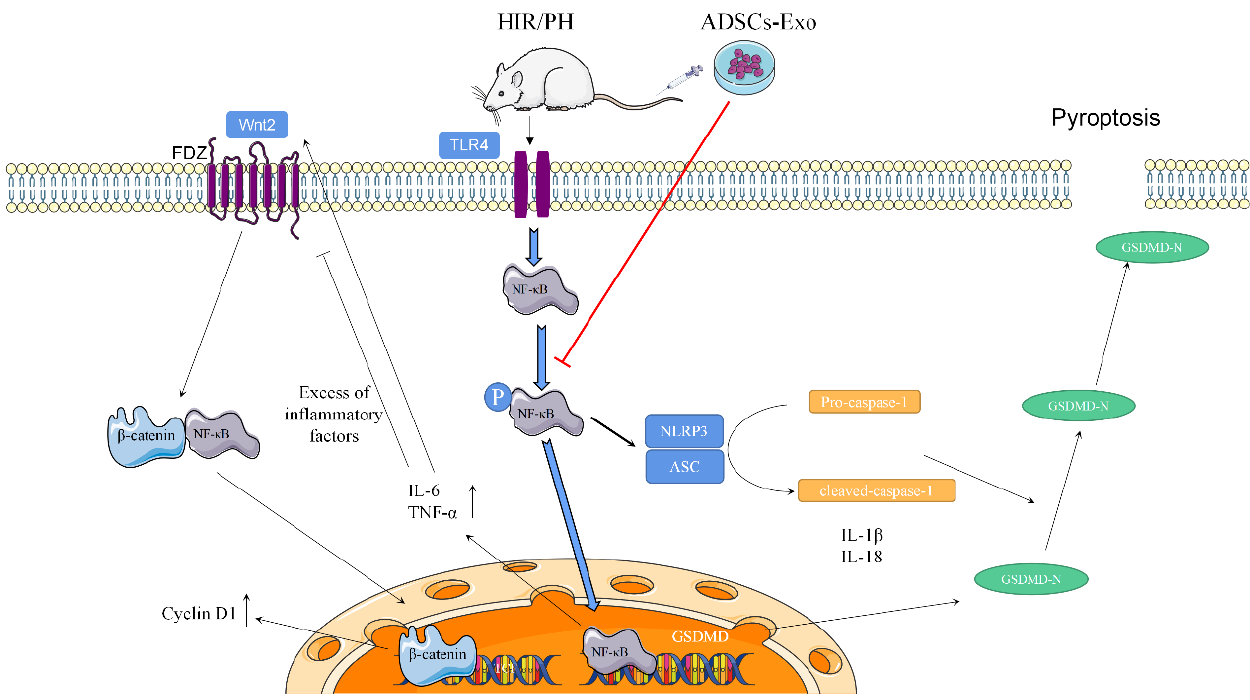
Figure 8. The mechanism of ADSCs-Exo alleviates pyroptosis and promotes tissue regeneration in the liver, which had ischemia – reperfusion and partial resection injury. The results show that ADSCs-Exo inhibits the NF- κ B pathway and activates the Wnt/ β -catenin signal pathway. The mechanism may be like that in Figure 8. Liver injury leads to an inflammatory response that will restrain hepatocyte proliferation if it is too serious. After transplanting ADSCs-Exo, the phosphorylation of NF- κB is inhibited and fails to stimulate the production of inflammation and the activation of GSDMD. On the other hand, ADSCs-Exo can activate the Wnt/ β -catenin pathway, and β -catenin translocates into the nucleus, increasing the expression of Cyclin D1 and thereby promoting cell proliferation. Ultimately, ADSCs-Exo play a role in mitigating cell damage and promoting tissue regeneration and functional recovery.